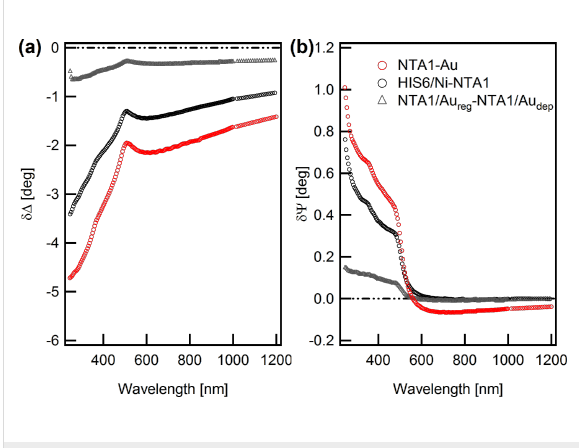
Figure 5: δΔ 2,1 and δΨ 2,1 spectra (black circles), related to the His 6 adsorption, are compared with δΔ 1',1 and δΨ 1',1 spectra (grey trian- gles) obtained after the completion of the imidazole/EDTA treatment. These difference spectra are referenced to the NTA/Au system. δΔ 1,0 and δΨ 1,0 spectra associated to the deposition of NTA1 on the Au sub- strate (red circles) are also reported for comparison.